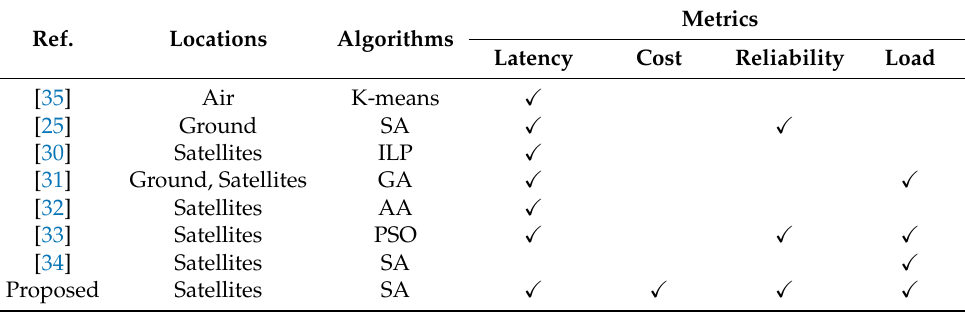
Table 1. Comparison of the proposed scheme with state-of-the-art methods. Ref. Locations Algorithms